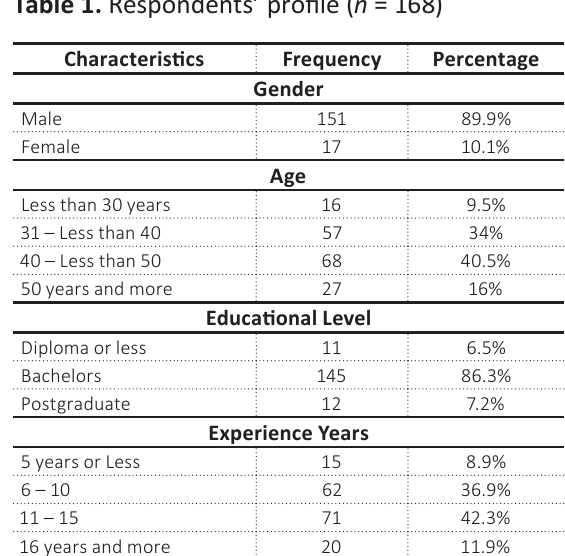
Table 1. Respondents’ profile ( n =